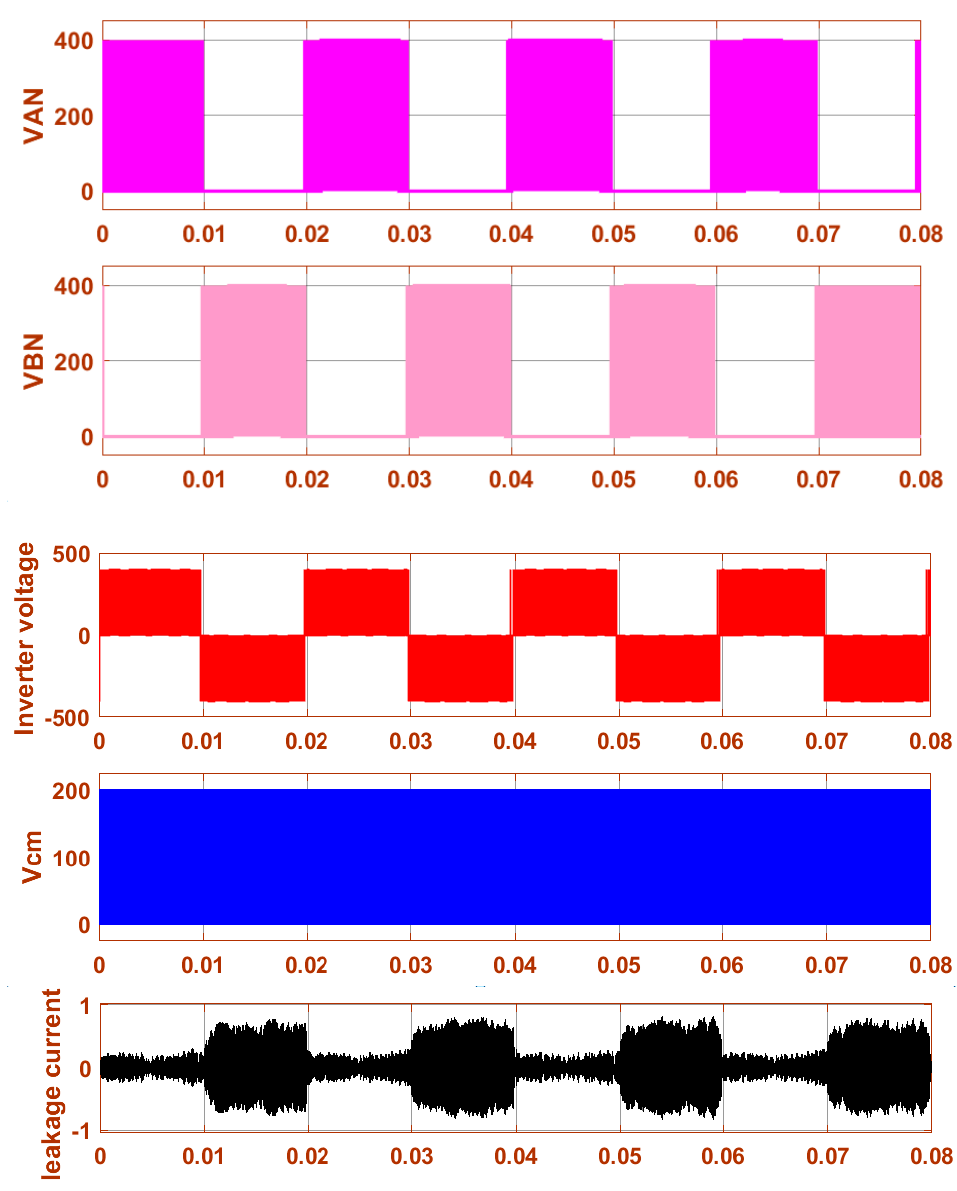
Figure 12. Waveform of V AN , V BN , inverter voltage and V cm , leakage current of H4 inverter.